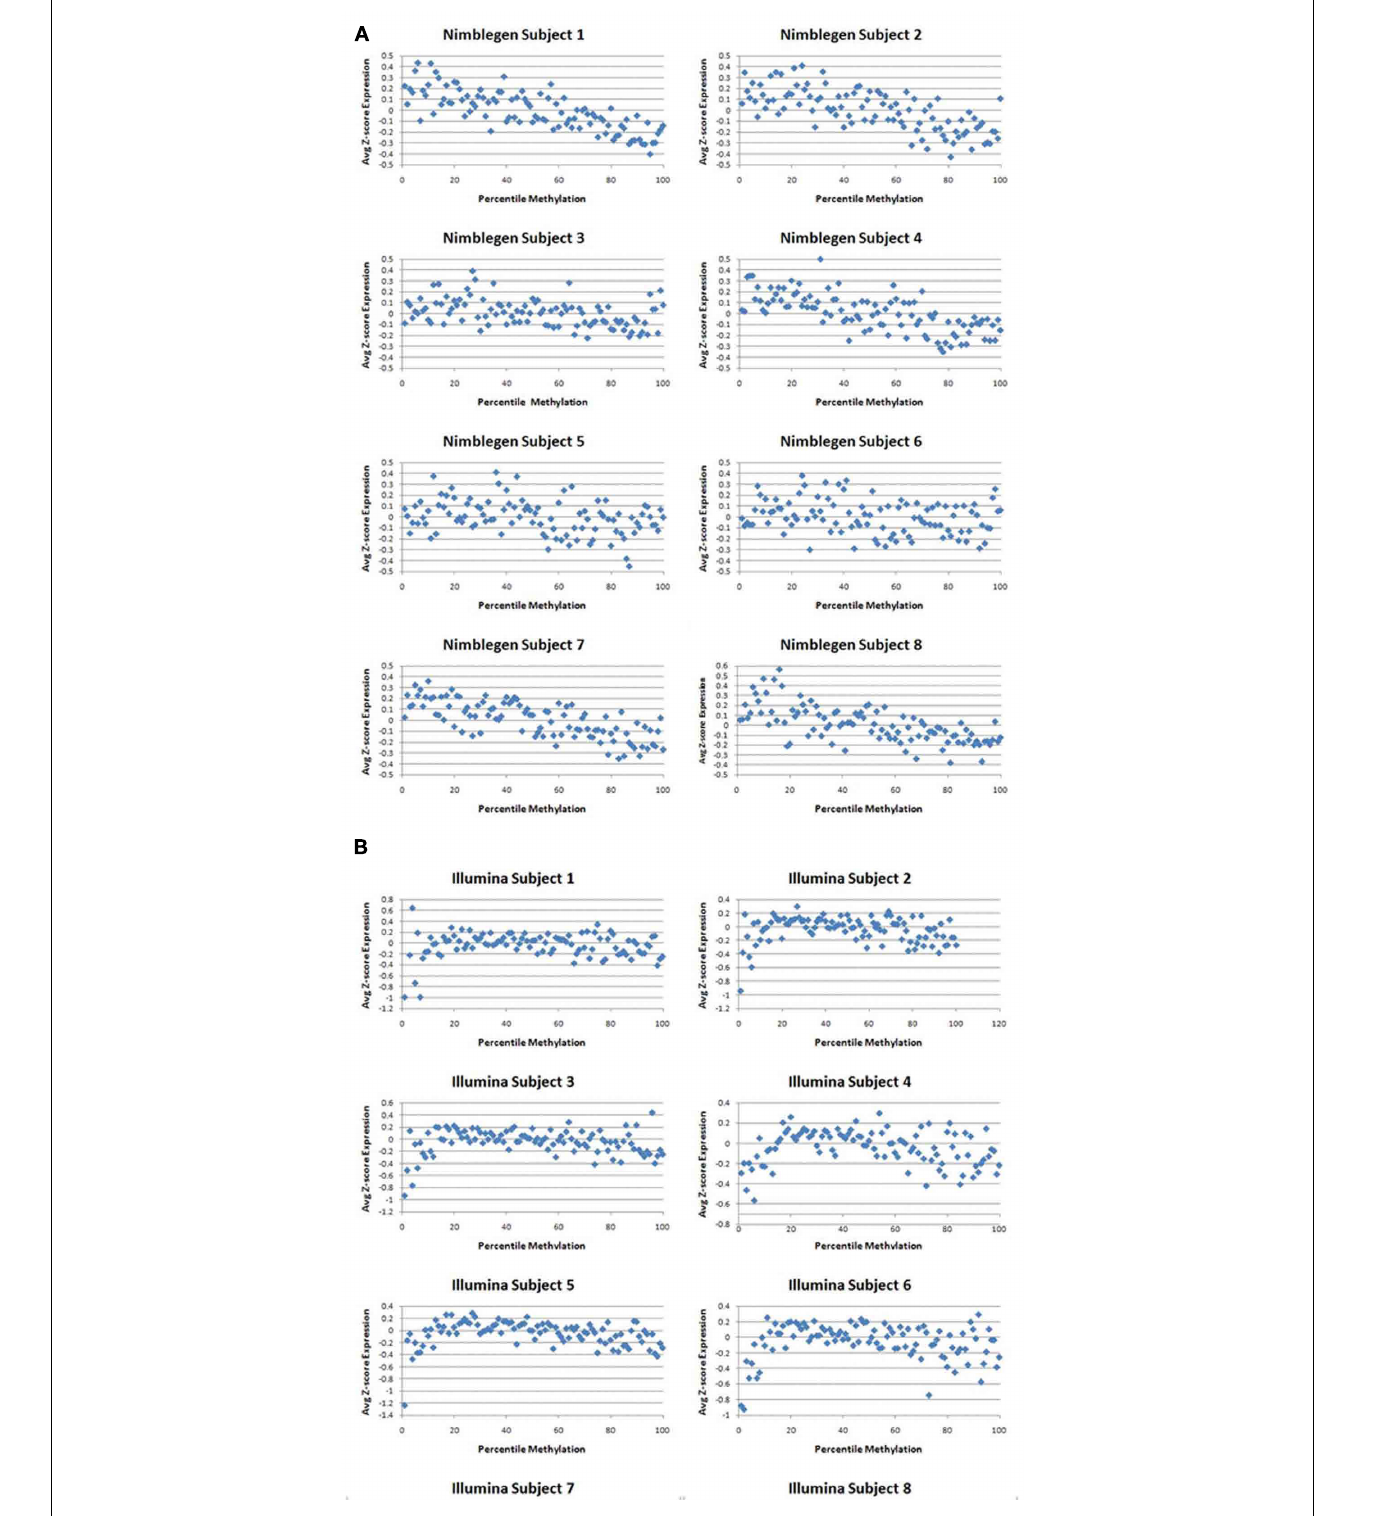
FIGUREA3 |The relationship between gene expression and gene methylation at each percentage point of the standardized distribution of gene expression data for the NimbleGen and the Illumina platforms.